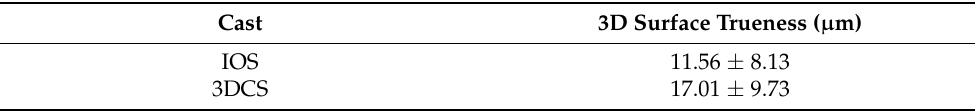
Table 1. Average 3D surface trueness ± standard deviation, expressed in µ m, of IOS and 3DCS compared to